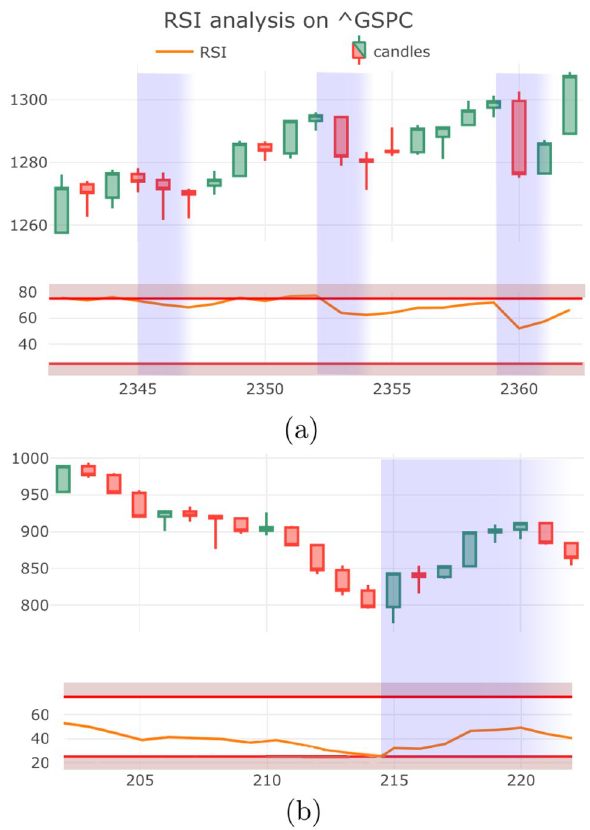
Figure 7. Examples of successful RSI signals. ( a ) RSI index is low, predicting reversal to an uptrend as observed. ( b ) RSI index is high, signally the start of a